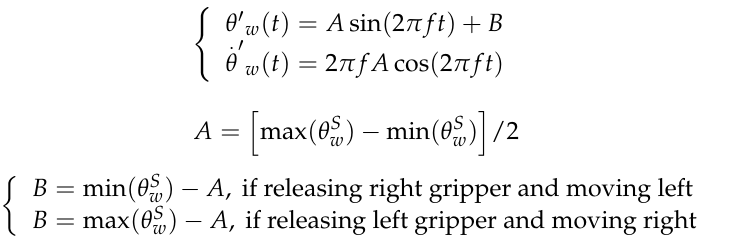
Parameter A is half the amplitude of the previous swing motion, expressed as (24). Parameter B is based on the direction of robot movement using (25), where superscript S is used to indicate that the wrist joint variables were acquired during the swing-up